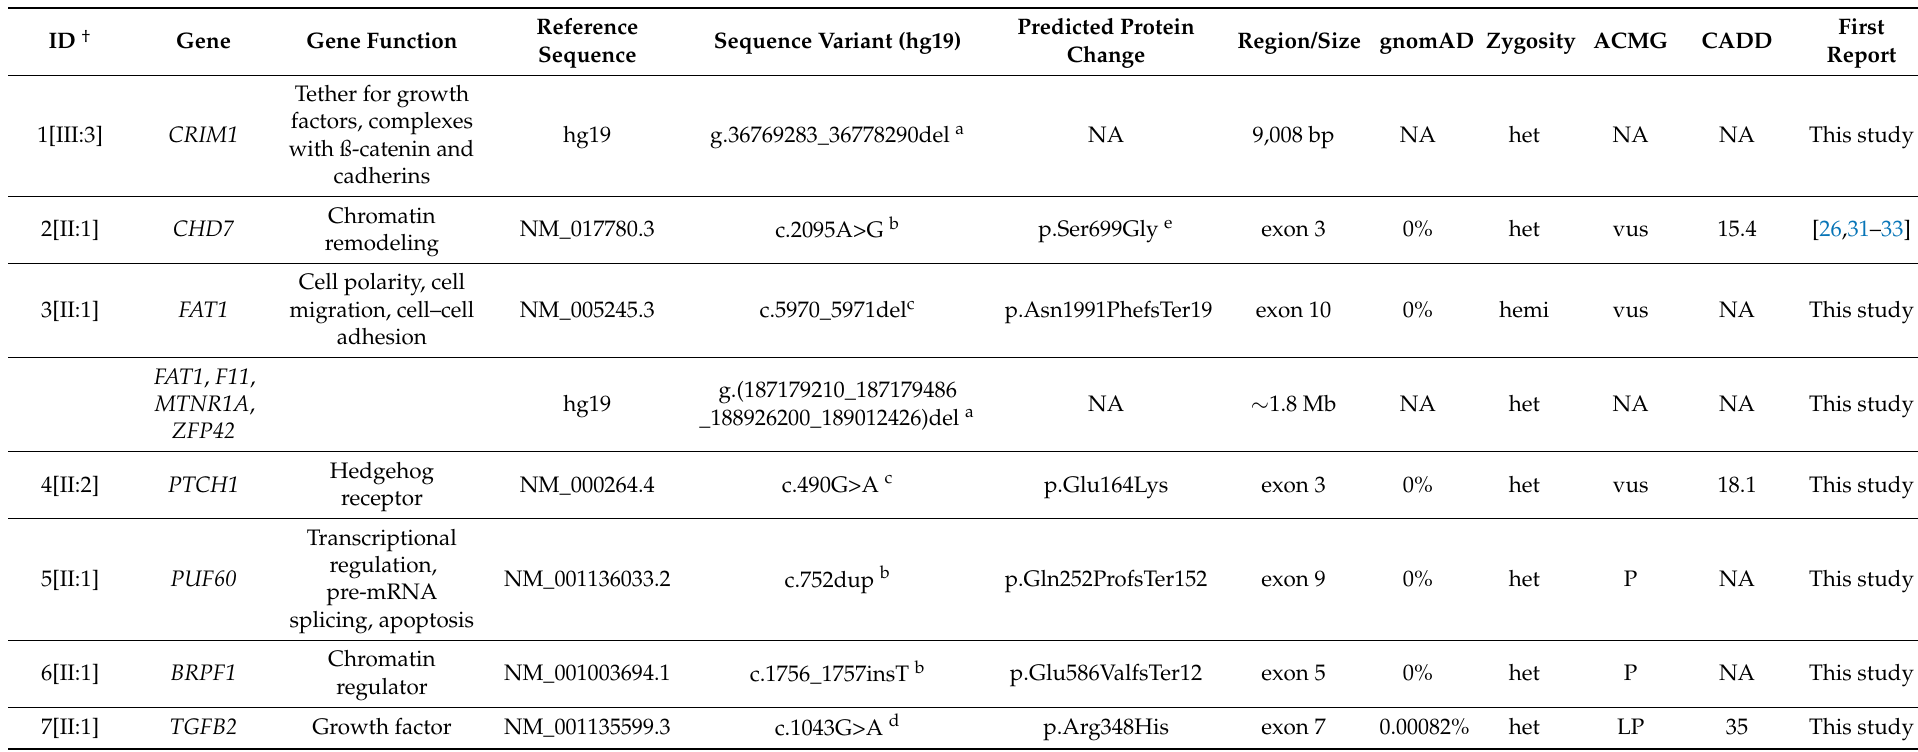
Table 2. Potentially disease-causing variants in index patients identified by whole-exome sequencing